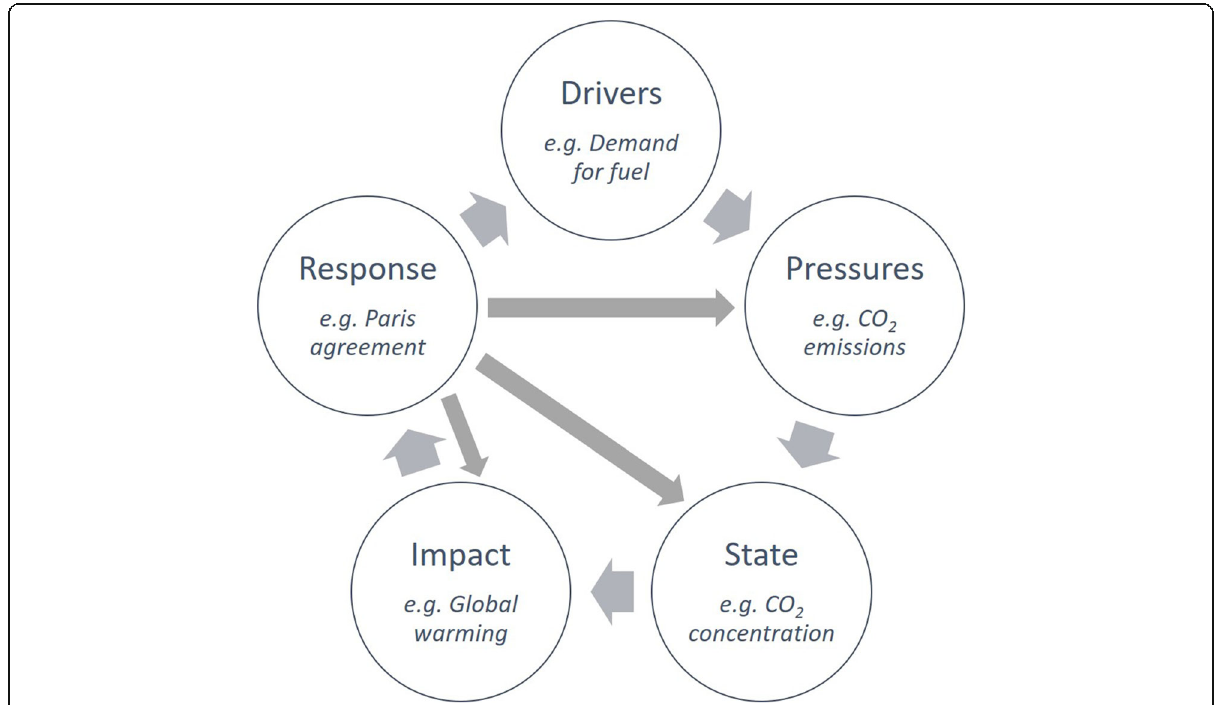
Fig. 4 The Driver Pressure State Impact Response